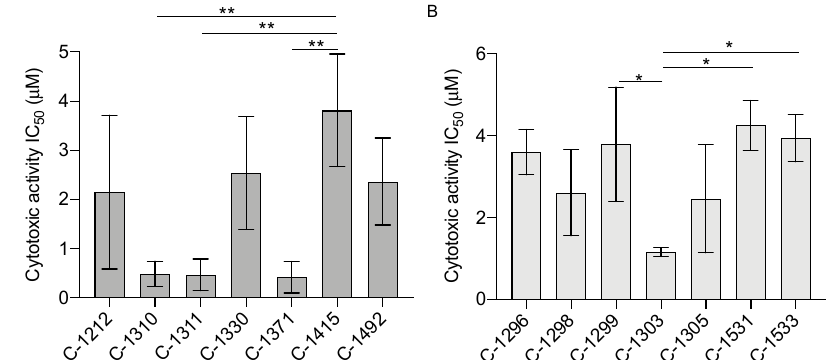
Figure 1. Cytotoxic activity of the ( A ) imidazoacridinones and ( B ) triazoloacridinones in AR-dependent prostate cancer LNCaP cells. IC 50 values were determined after 72 h of treatment based on the dose–response curves and presented as bar graphs. Data are the mean ± SD, n = 3. Significance: One-way ANOVA with Tukey’s multiple comparison test; ** p < 0.01, * p < 0.05.